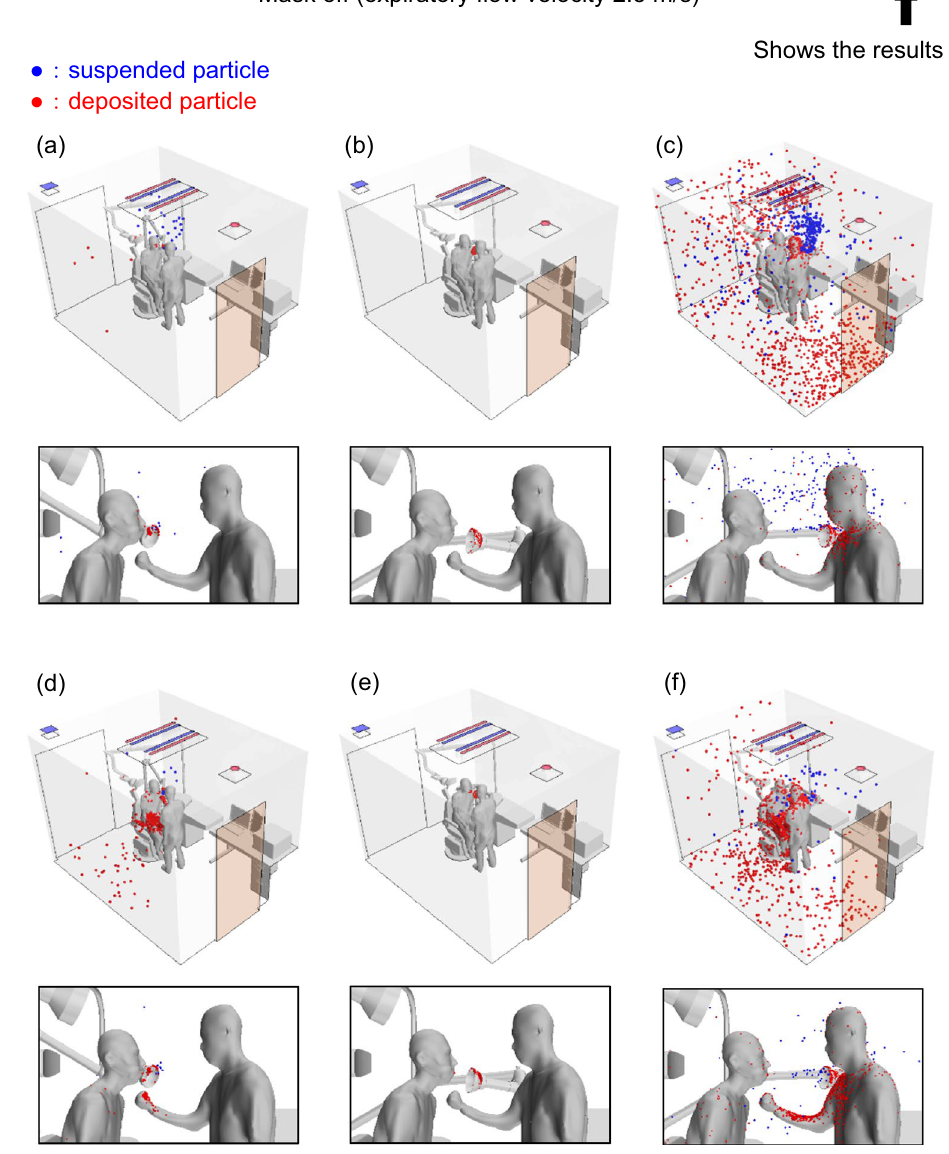
Figure 3. Comparison of simulated distributions of suspended (blue) and deposited (red) particles with the suction device in three different positions shown in this figure, 100 s after the patient begins exhaling at a constant rate of 2.5 m/s (Case X) and assuming no evaporation. ( a ) Suction port placed near the patient’s mouth (small particles). ( b ) Suction port placed approximately 15 cm from the patient’s mouth (small particles). ( c ) Suction port is placed approximately 35 cm from the patient’s mouth (small particles). ( d ) Suction port is placed near the patient’s mouth (large particles). ( e ) Suction port is placed approximately 15 cm from the patient’s mouth (large particles). ( f ) Suction port is placed approximately 35 cm from the patient’s mouth (large